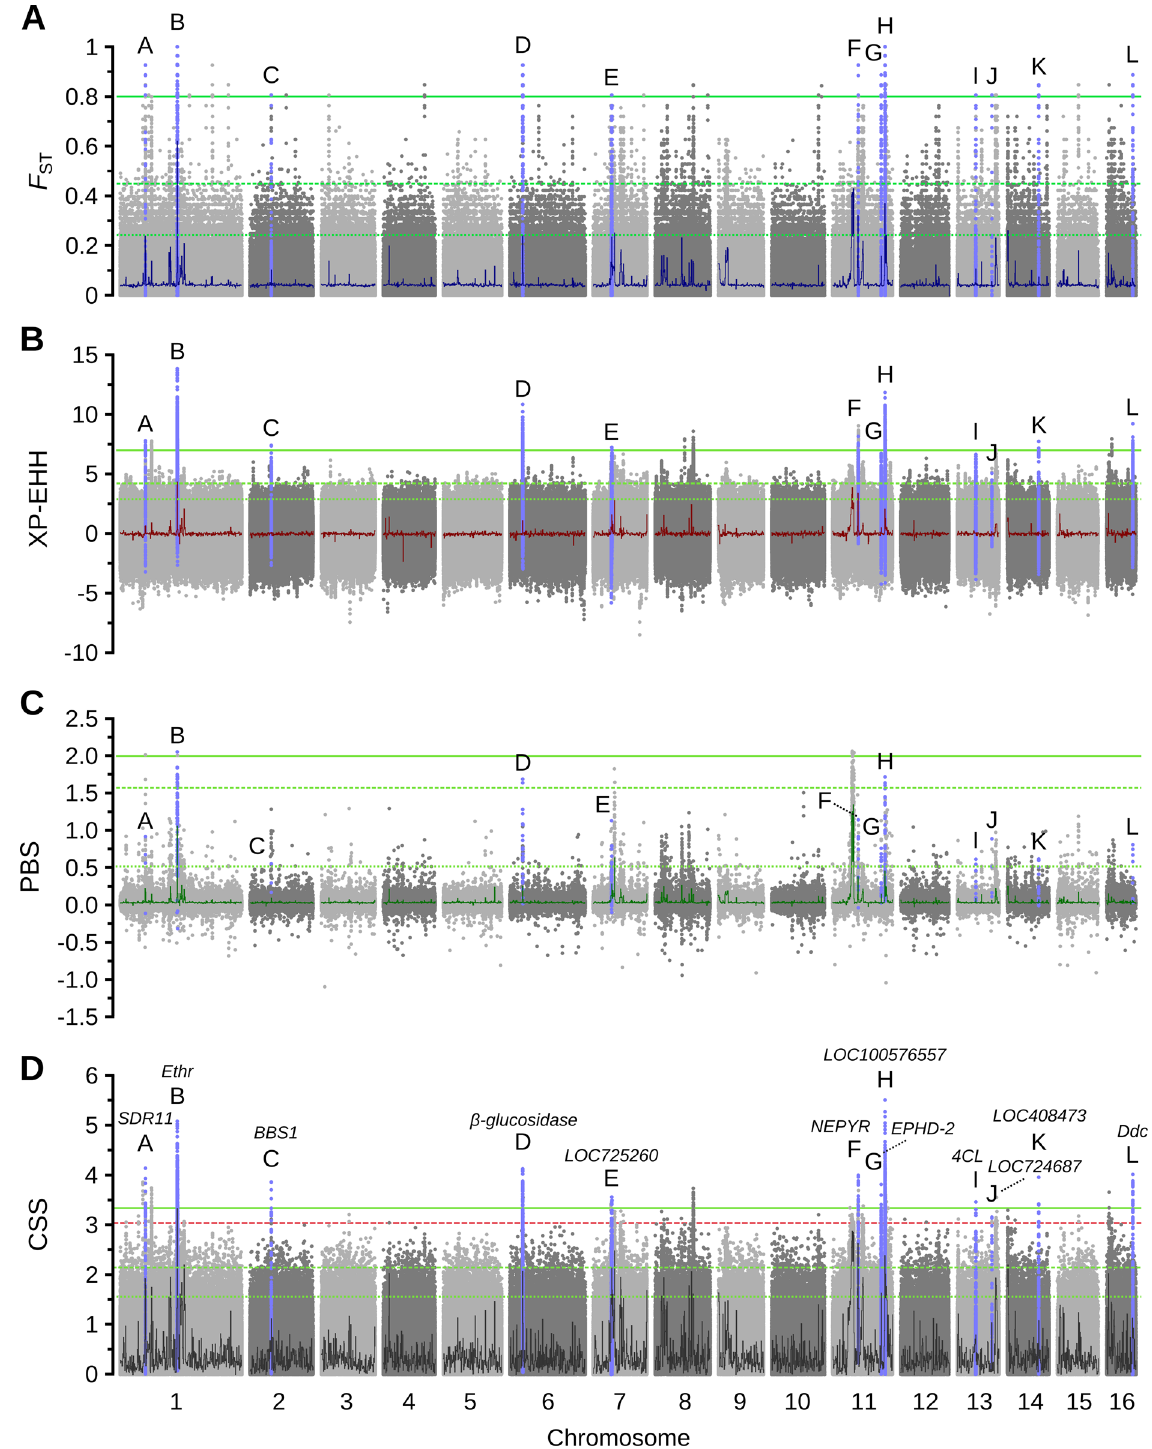
Fig 3. A genome-wide scan for selection identifies several candidate loci in the Cape bee genome. Selection statistics associated with every SNP segregating between the Cape bees ( A . m . capensis ) and the African background population ( scutellata + adansonii ) (n = 6.2×10 6 ). (A) The Fixation index ( F ST ). Dark blue line is F ST across 100kbp non-overlapping windows. Green lines are the 99.99% percentile (solid line; F ST > 0.44; n = 624), the 99.9% percentile (dashed line; F ST > 0.80; n = 6245) and the 99.5% percentile (dotted line; F ST > 0.24; n = 31,226). Highlighted in light blue are all SNPs associated with the 12 candidate